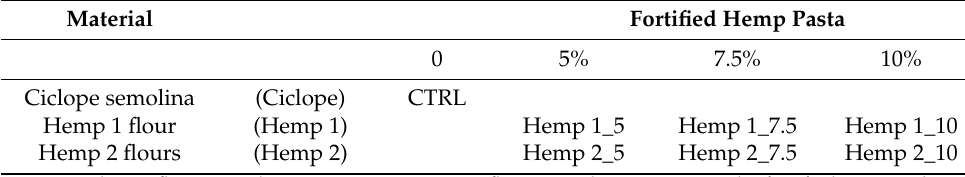
Table 1. Ciclope and fortified pasta samples. Material Fortified Hemp Pasta Ciclope semolina Hemp 1